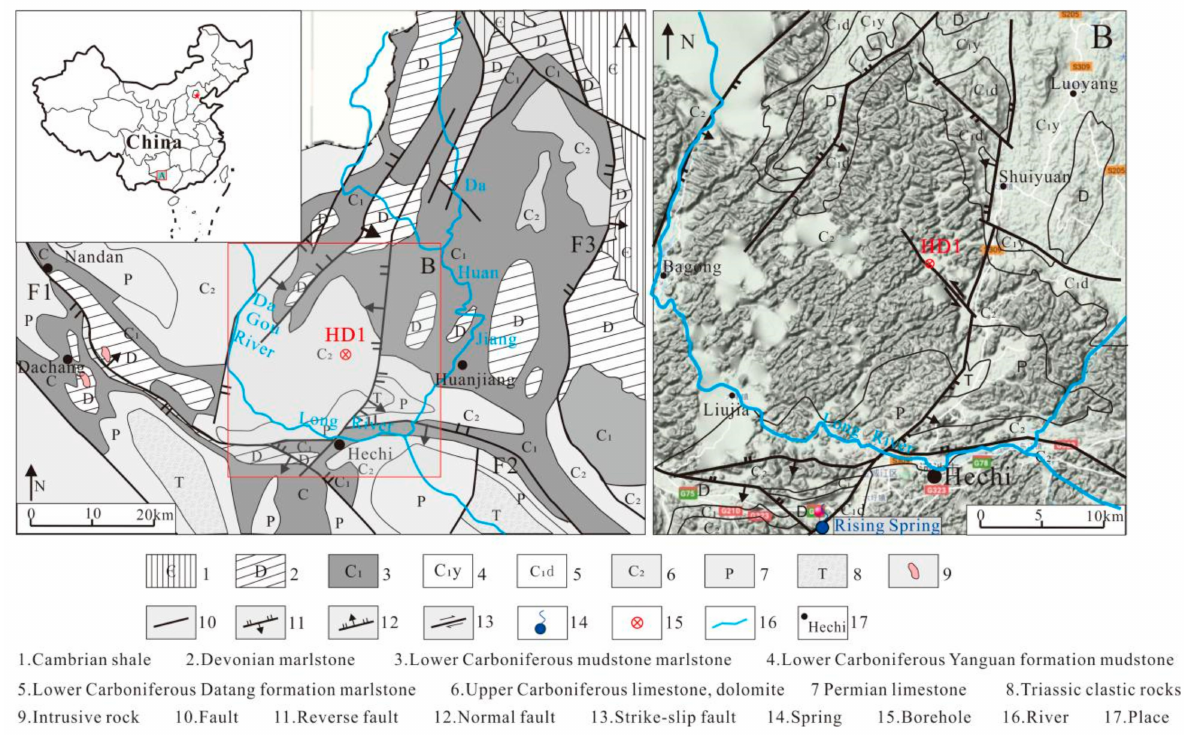
Figure 1. Tectonic location of the HuanJiang area. ( A ) Regional geological map of Huanjiang syncline, Guangxi. ( B ) Karst geomorphic map of Huanjiang syncline, Guangxi. Note: Figure 1A is from a geological survey of Guangxi, 1971; Figure 1B is from Google